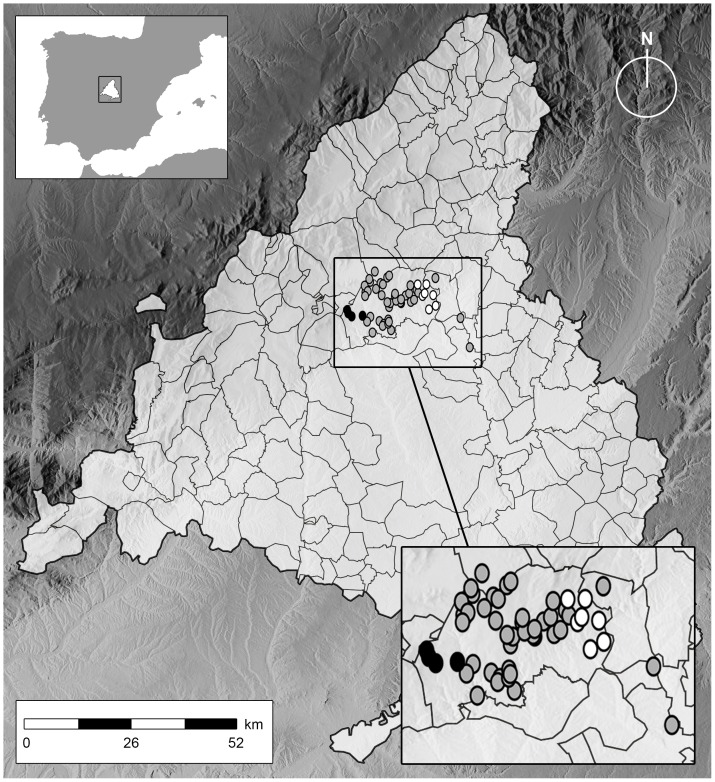
Cluster of herds showing significantly (p<0.05) low (black dots) or high (white dots) values for the log-transformed β coefficient as determined by Getis-Ord G*i within a high risk area of the ACM.